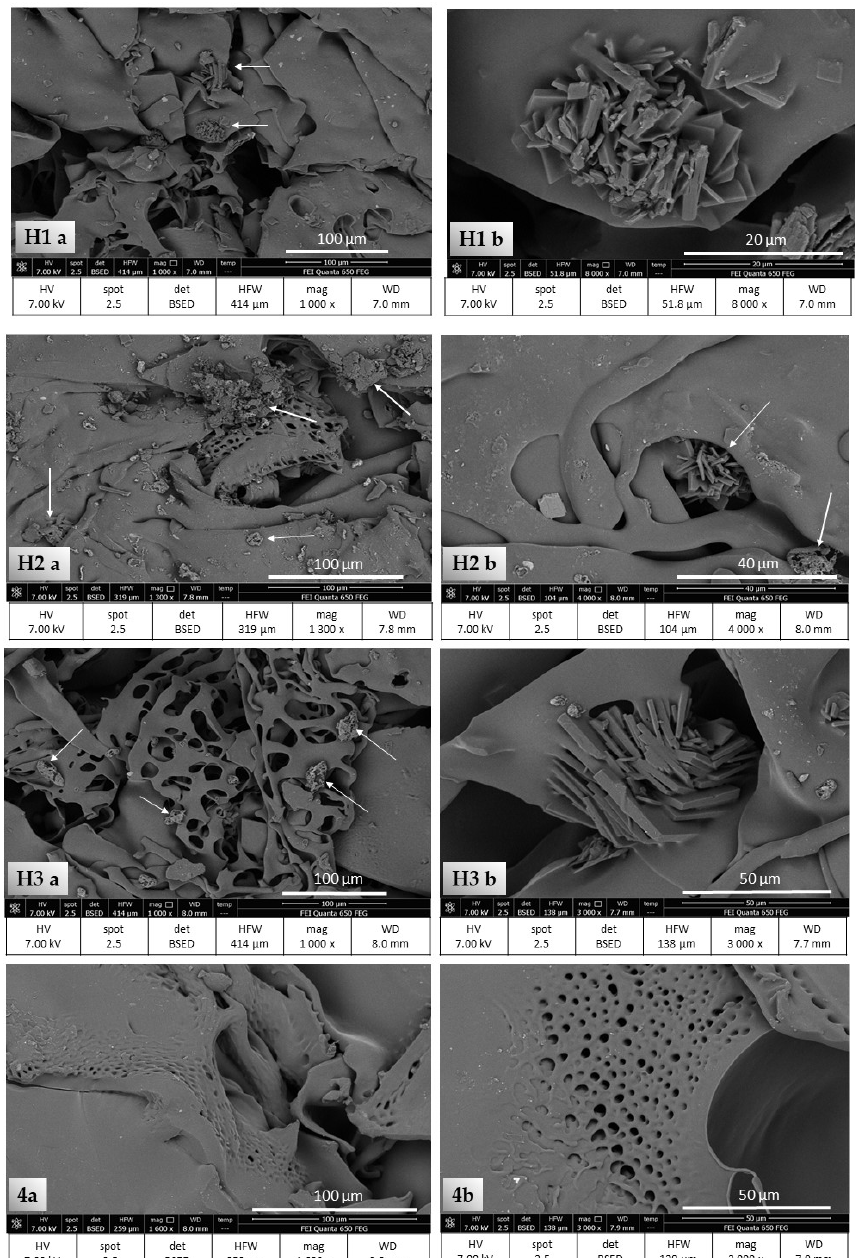
Figure 5. SEM images of the test samples: 1a and 1b —sample H1, 2a and 2b —sample H2, 3a and 3b —sample H3, 4a and 4b —hydrogel sample without TC. Images a —magnification 1000–1600, b —magnification 3000, 4000 and 8000.